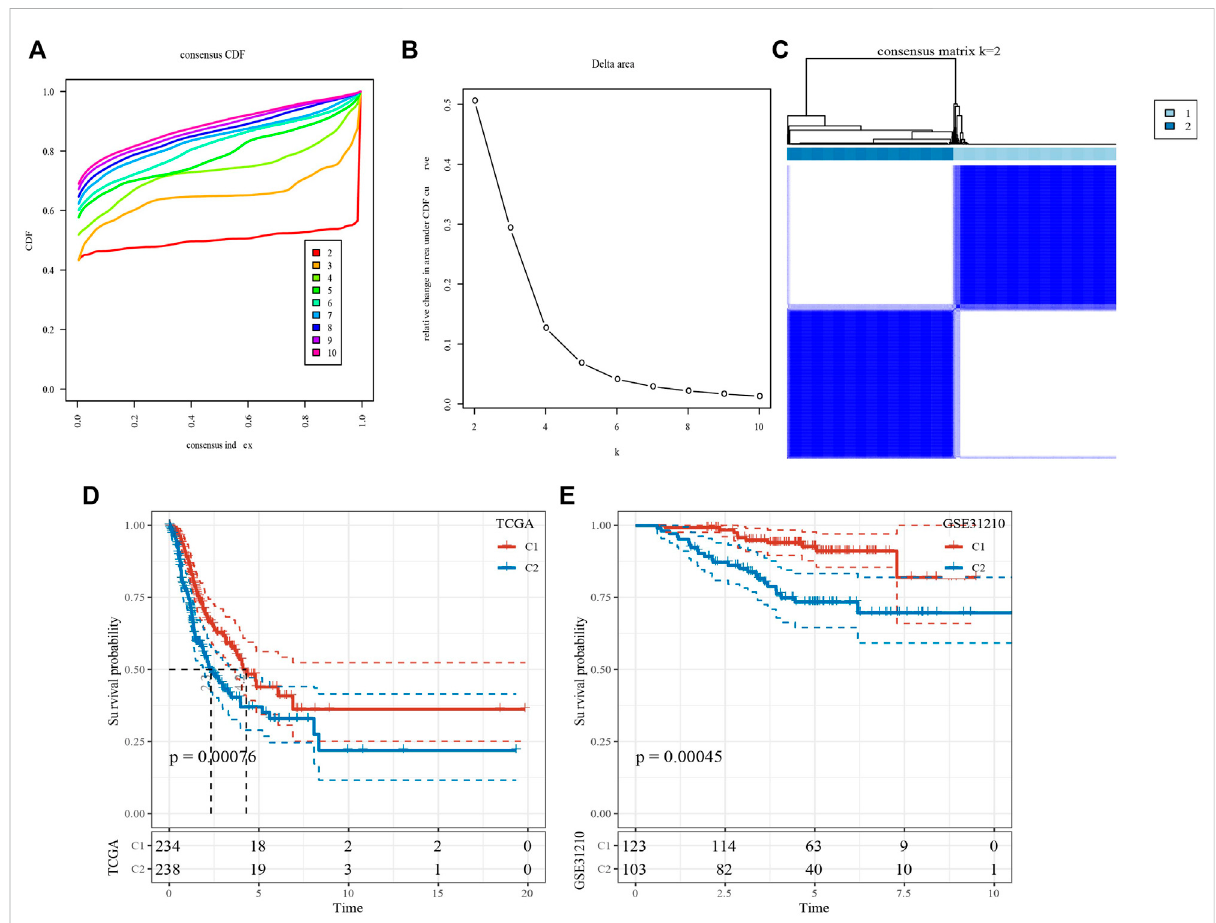
FIGURE 2 Identi fi cation of molecular subtypes. (A) Cumulative distribution function. (B) Delta area. (C) Heatmap of sample clustering when k = 2. (D) KM survival analysis of C1 and C2 in TCGA-LUAD dataset. (E) KM survival analysis of C1 and C2 in GSE31210